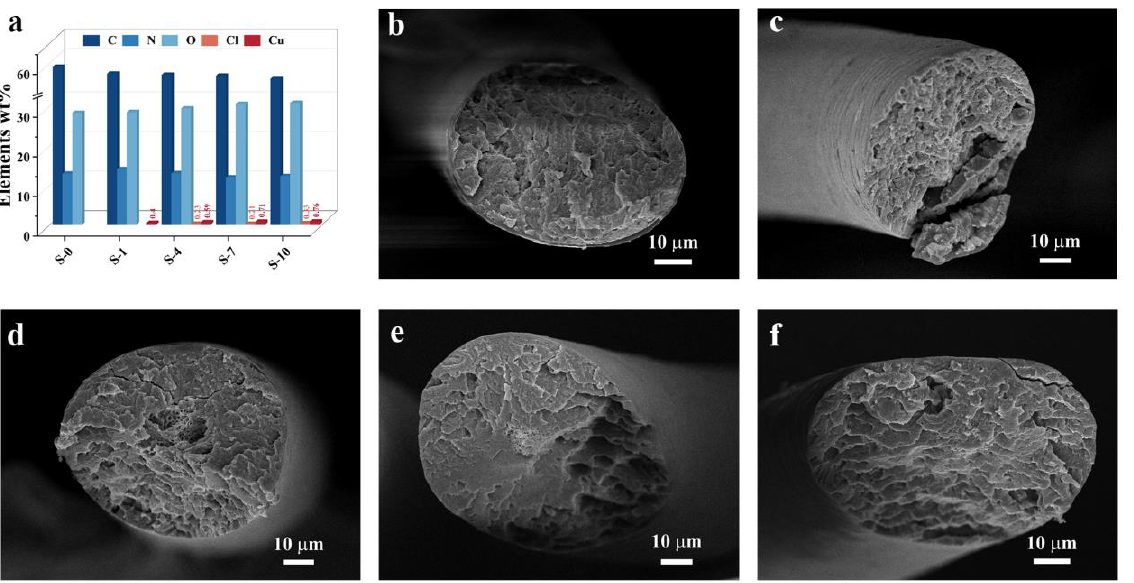
Figure 4. ( a ) Elements distributed on the hair cross-section; ( b – f ) cross-sectional SEM images of the hair samples for S-0, S-1, S-4, S-7, and S-10.